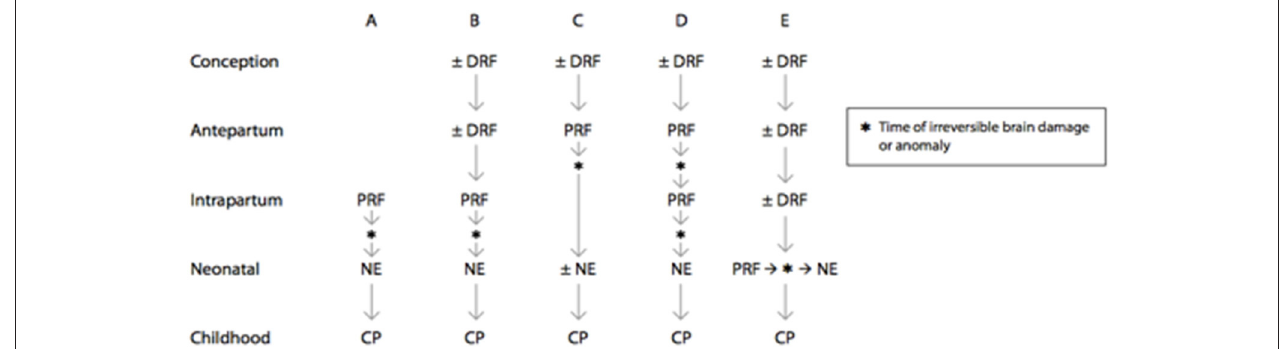
FIGURE 6 | Prenatal and perinatal causal pathways to cerebral palsy in term infants. Distal risk factors exert a pathogenic effect on fetal brain development starting at a time that is remote from the onset of irreversible brain injury. Examples include genetic abnormalities, environmental, and sociodemographic factors, as well as specific placental abnormalities. Proximal risk factors exert pathogenic effects on fetal brain development at a time that closely predates or coincides with the onset of irreversible brain injury. Examples include abruptio placentae, chorioamnionitis, and twin–twin transfusion. There are multiple potential causal pathways that lead to cerebral palsy in term infants, and the signs and symptoms of neonatal encephalopathy may range from mild to severe, depending on the nature and timing of the brain injury. (A) Intrapartum brain injury that is due to a proximal risk factor may lead to neonatal encephalopathy and subsequent cerebral palsy. (B) Intrapartum brain injury may be the result of both distal and proximal risk factors that predispose the fetus to brain injury and cerebral palsy. (C) Brain injury or anomaly may occur in the antepartum period as a result of distal and proximal risk factors. When brain injury or anomaly occurs at a time that is remote from the delivery process, neonatal encephalopathy may or may not be seen after birth. (D) Brain injury may occur at multiple points during gestation. (E) Proximal risk factor and brain injury may occur in the neonatal period following predisposing distal risk factors. DRF, distal risk factor; PRF, proximal risk factor [(15), updated